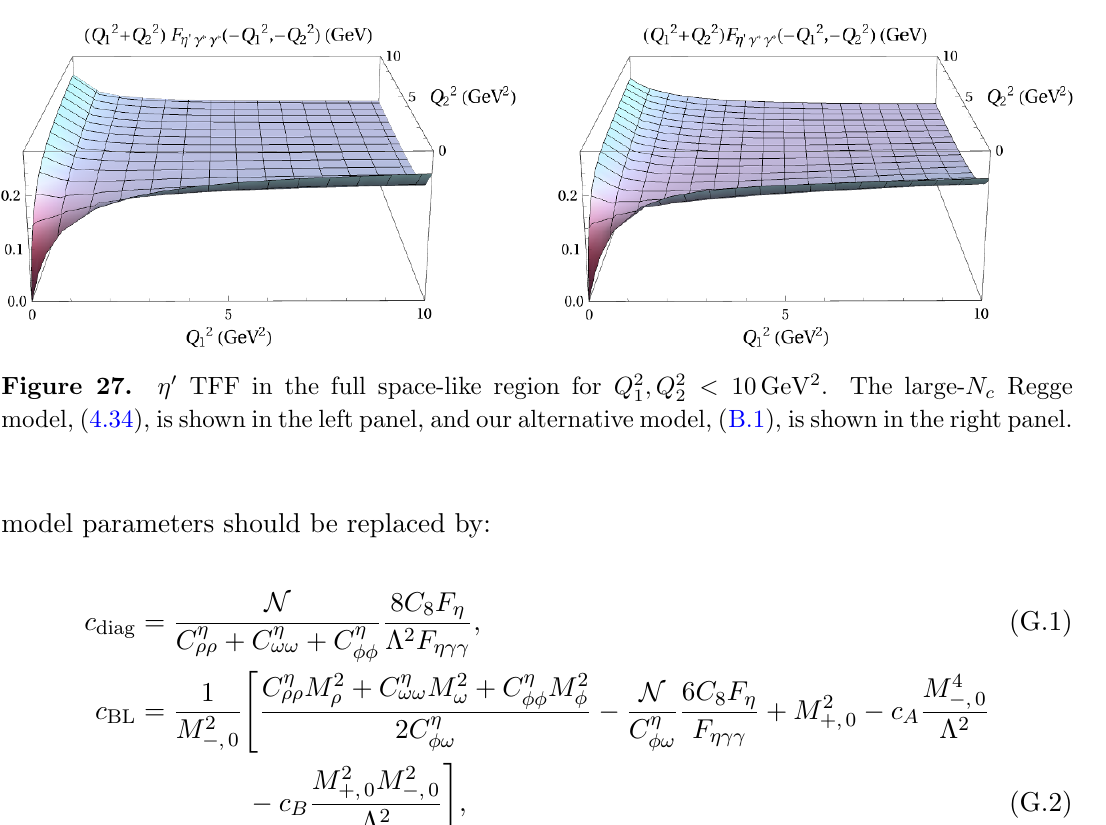
Figure 26. (cid:17) TFF in the full space-like region for Q 2 model, (4.34), is shown in the left panel, and our alternative model, (B.1), is shown in the right panel.